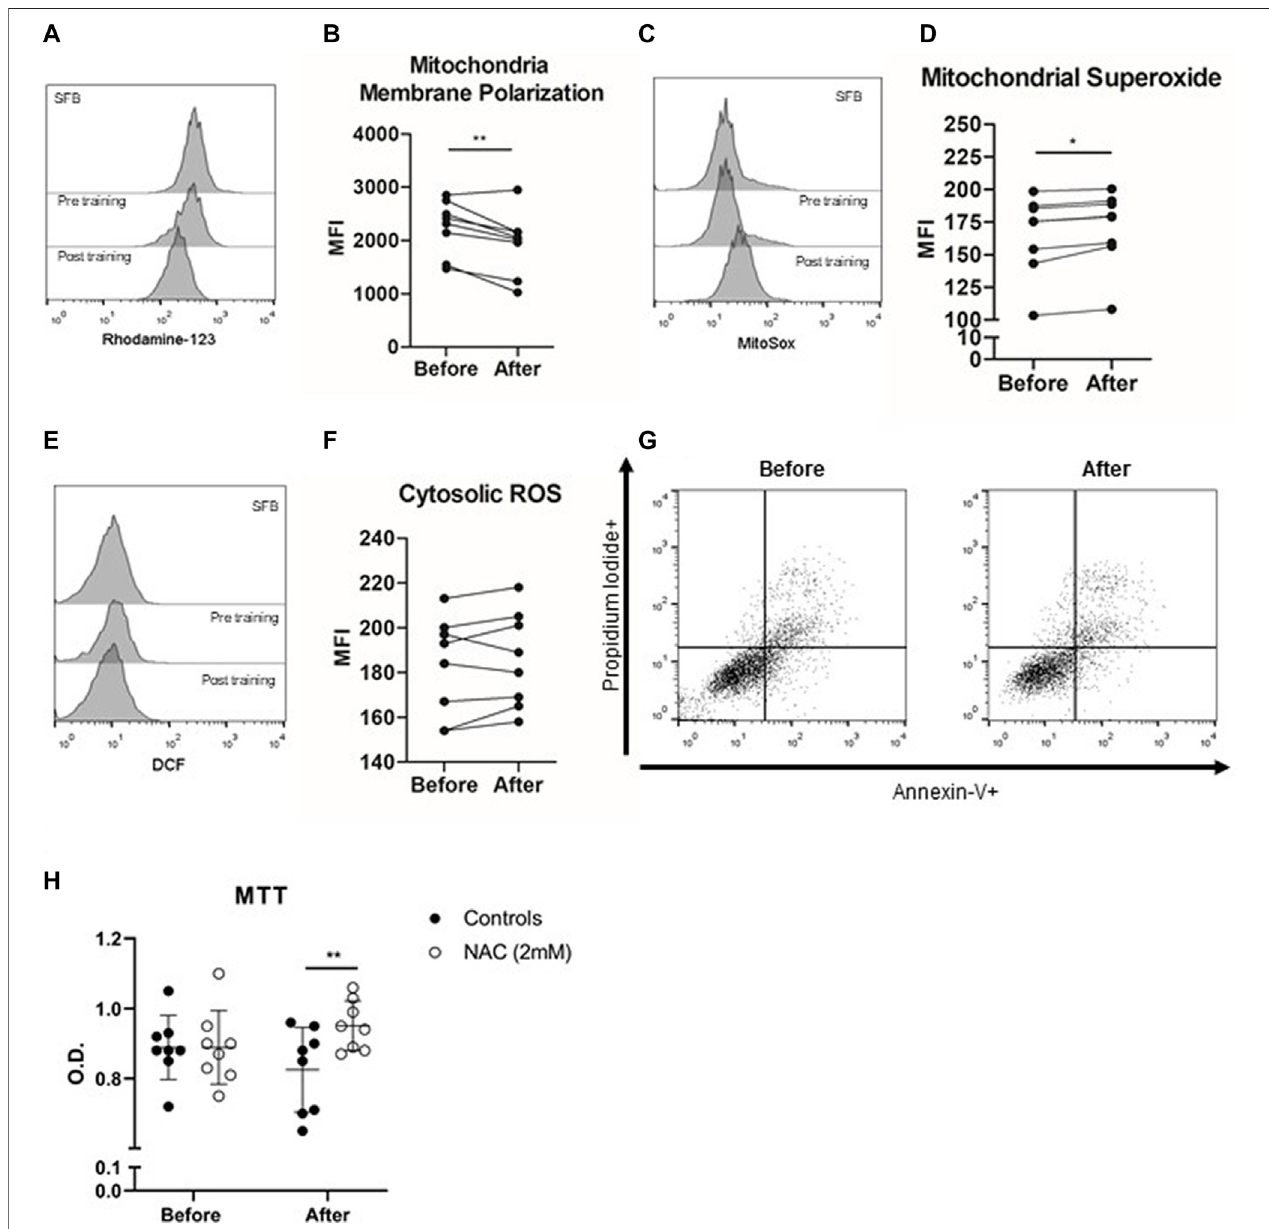
FIGURE 2 | Anticarcinogenic effects of plasma from trained older adults ( n = 8) in the PC3 prostate cancer cell line. PC-3 Prostate cancer cell lines were incubated with the plasma of institutionalized older adults obtained before training and 48 h after 8 weeks of exercise training. The histogram of rhodamine-123 (A) evaluated the mitochondrial membrane potential (B) , the histogram of Mitosox (C) quanti fi ed mitochondrial superoxide (D) generation, and the histogram of DCF (E) evaluated cytosolicROS (F) production after12hofPC3celllineincubationwithplasmaobtainedbeforeandafter exercisetraining. Apoptosis (Annexin-V+ cells)ornecrosis (propidium iodide + cells) did not differ before and after comparison (G) . (H) Cell viability (MTT) was evaluated without and with NAC concomitant with the incubation of PC3cellswithplasmafromolderadults.Allexperimentsweredoneintriplicate,andtheresultsareshownasthemeanoftriplicatesfromthreeindependentexperiments. * p < 0.05; ** p < 0.01; *** p <